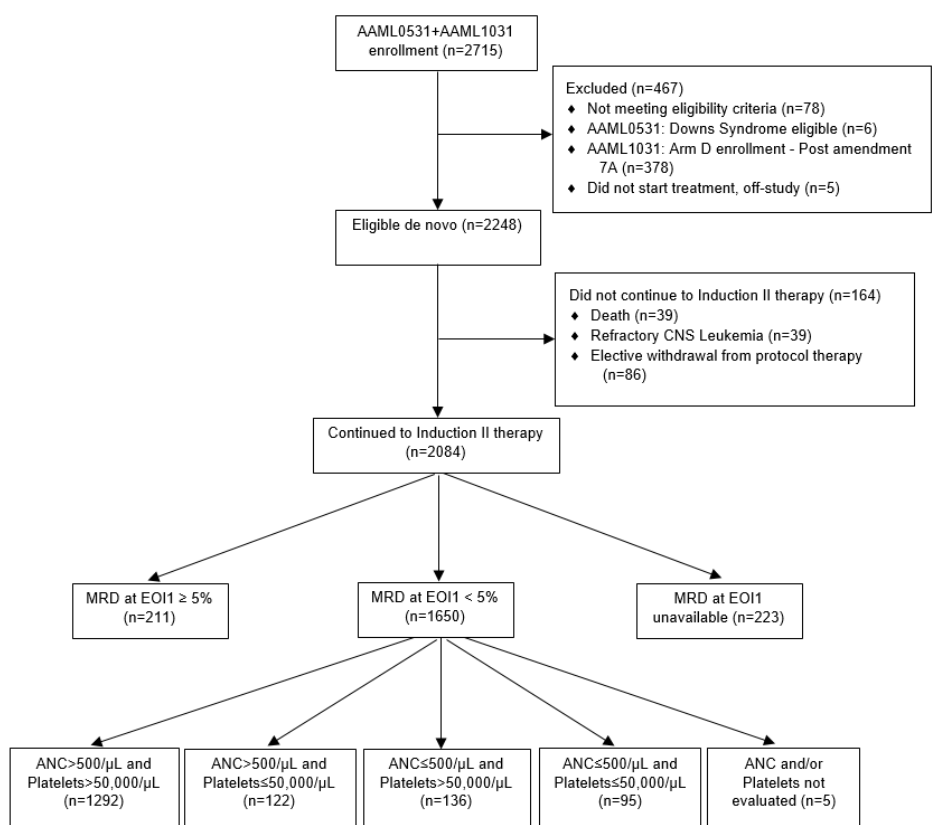
Figure 1. CONSORT diagram.